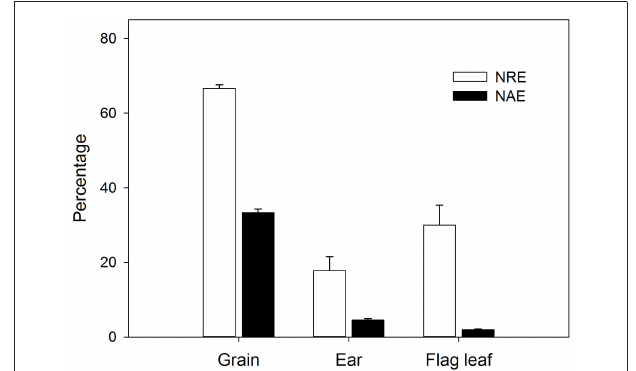
FIGURE 4 | N remobilization efficiency (NRE) and N absorption efficiency (NAE) at 2 weeks after anthesis of the grain, ears and flag leaves. Values represent means across all the genotypes for 3 replicates. Errors bars represent